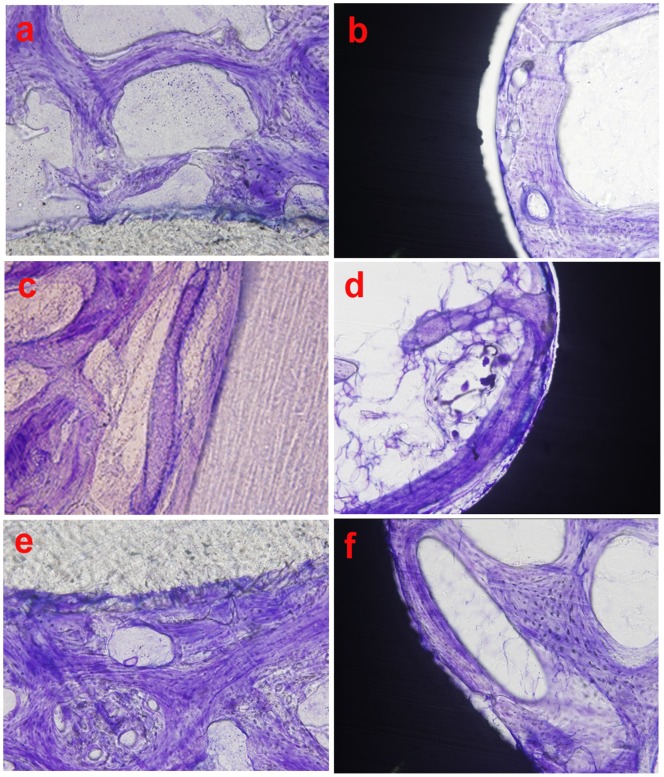
Toluidine blue (TB) staining of the screw-bone interface at different time points after operation (×200).(a) The bioactive screw-bone interface at 4 weeks after implantation. (b) The metallic screw-bone interface at 4 weeks after implantation. (c) The bioactive screw-bone interface at 8 weeks after implantation. (d) The metallic screw-bone interface at 8 weeks after implantation. (e) The bioactive screw-bone interface at 24 weeks after implantation. (f) The metallic screw-bone interface at 24 weeks after implantation.